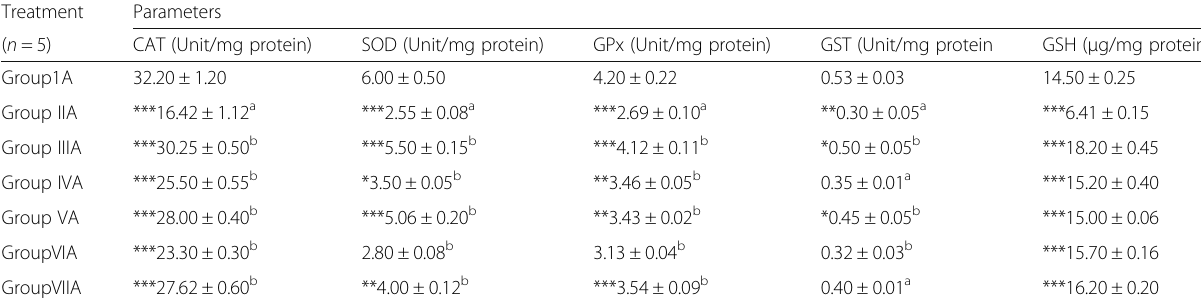
Table 1 Effect of methanol extract of T. conophorum seeds on liver antioxidant status in CCl 4 induced hepatotoxicity in rats after 24 h of